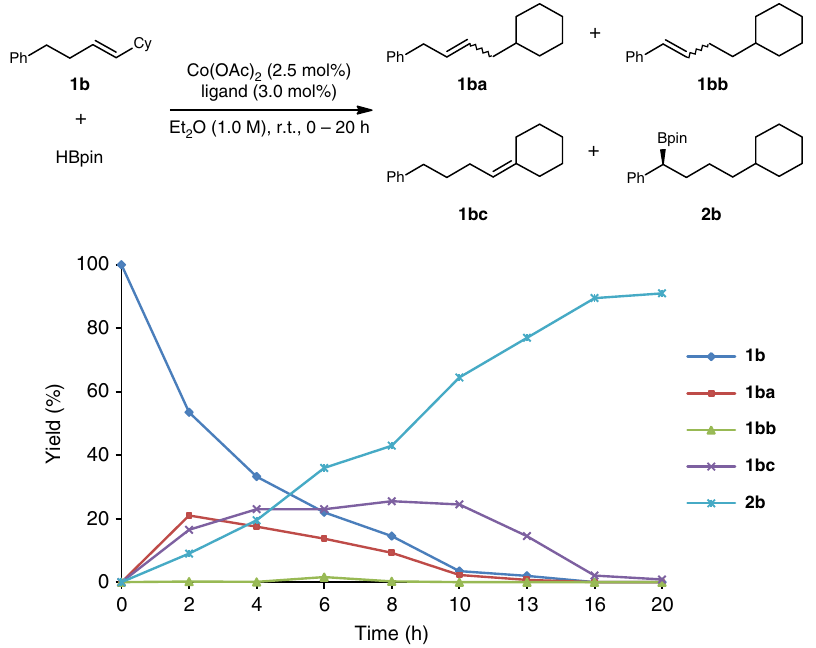
Fig. 5 The time course study of 1b . Reaction conditions: 1b (0.5 mmol), HBpin (0.6 mmol), Co(OAc) 2 (2.5 mol%), L8 (3.0 mol%), Et 2 O (1 M), r.t., 0 – 20